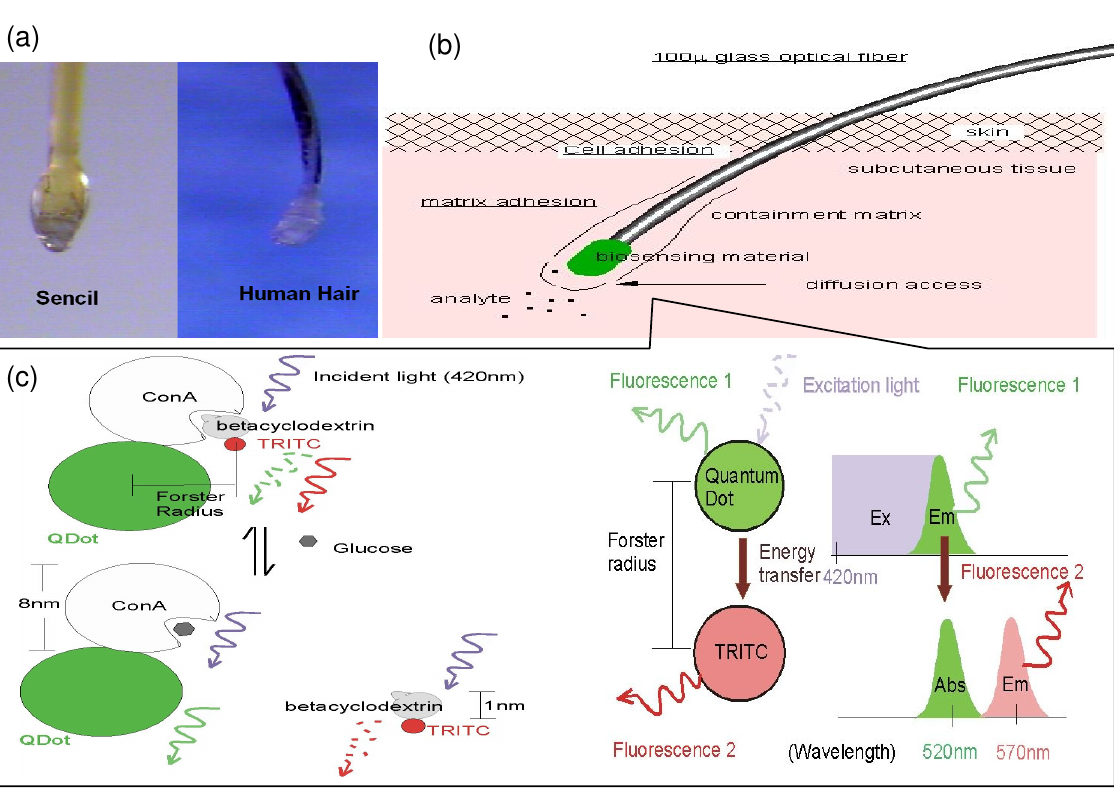
Figure 1. Illustration of the Sencil TM system for glucose sensing. (a) Similarity of shape and size between Sencil TM and human hair with attached follicle (white bar = 100 µm). (b) Sensor components and relationships to tissue in vivo . (c) Changes in FRET between fluorophores covalently immobilized on the flexible PEG matrix depend on changes in the distance between them, which in turn depends on the competitive natural affinity between Con A and various saccharides such as betacyclodextrin and glucose. The figure is modified with permission from [10], published by Biosensors Bioelectronics,